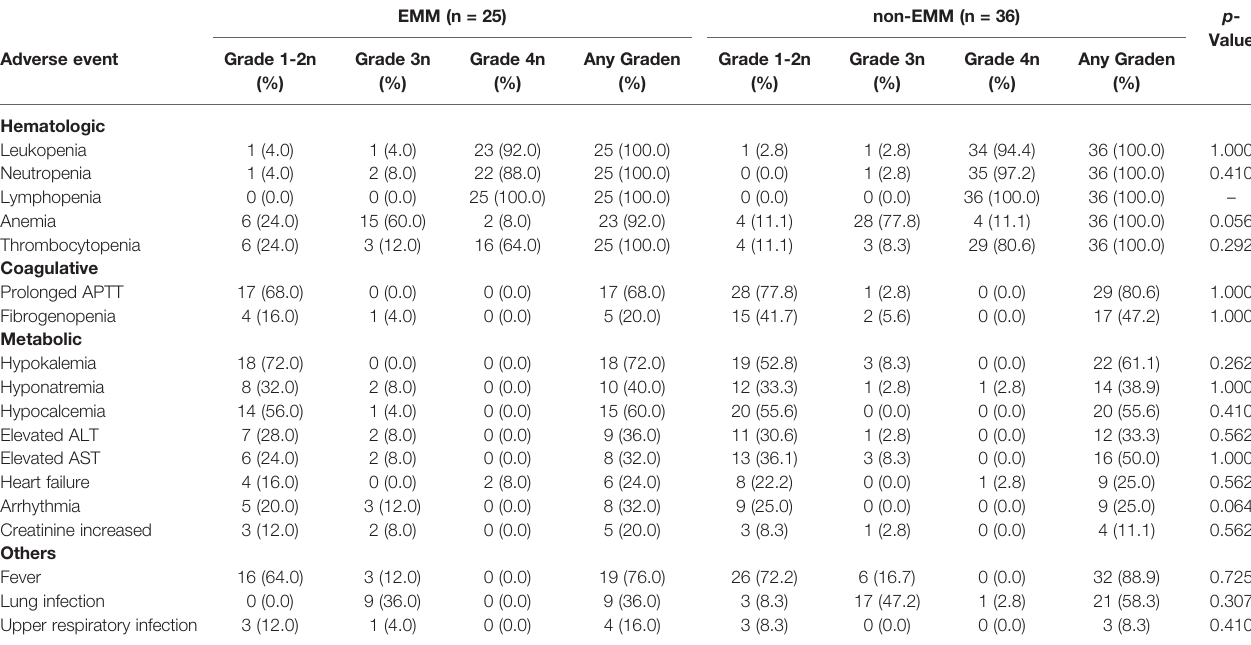
TABLE 3 | Comparison of adverse events occurred in 10% or more patients during the fi rst eight weeks post-infusion between EMM and non-EMM patients in two clinical trials conducted in our center. EMM (n =